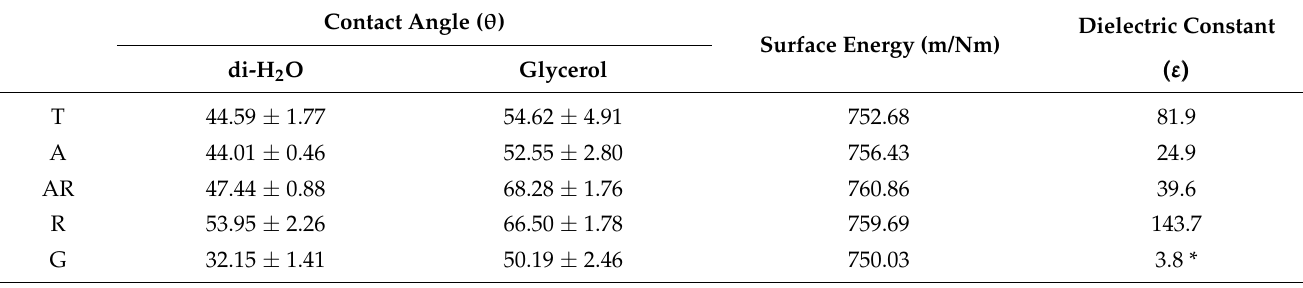
Table 1. Analysis results of wettability and dielectric constant on different test